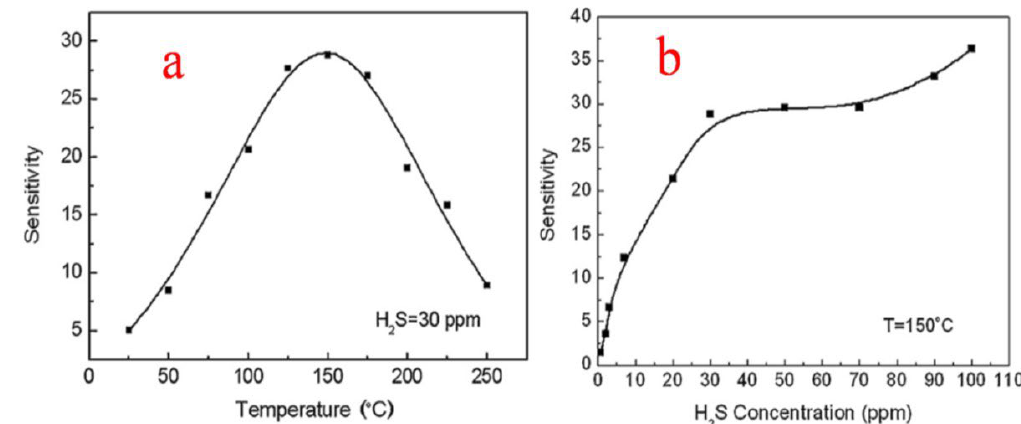
Figure 22. ( a ) Response sensitivity at different operation temperatures for H 2 S at 30 ppm. ( b ) Re- sponse sensitivity to different concentrations of H 2 S gas at optimal temperature. (Reprinted with permission from [37]. Copyright 2009, Elsevier).